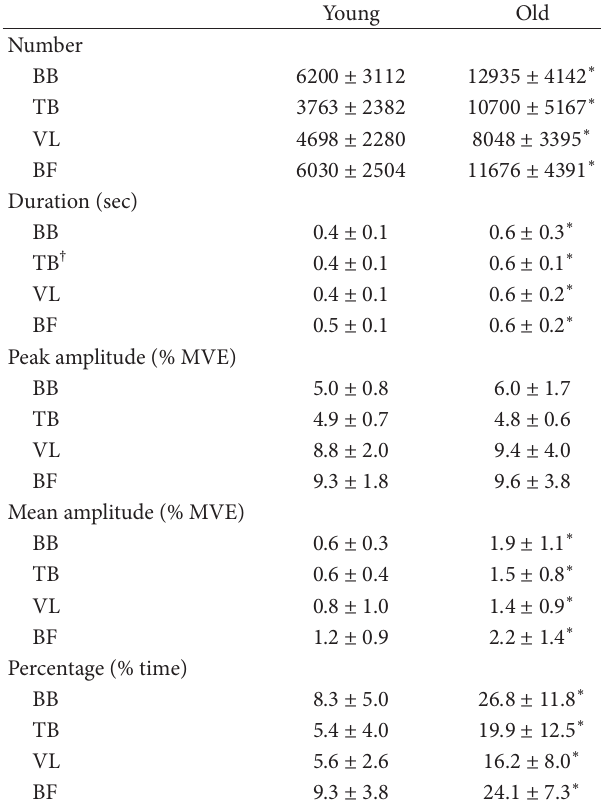
Table 1: Age-related differences in burst characteristics for each muscle